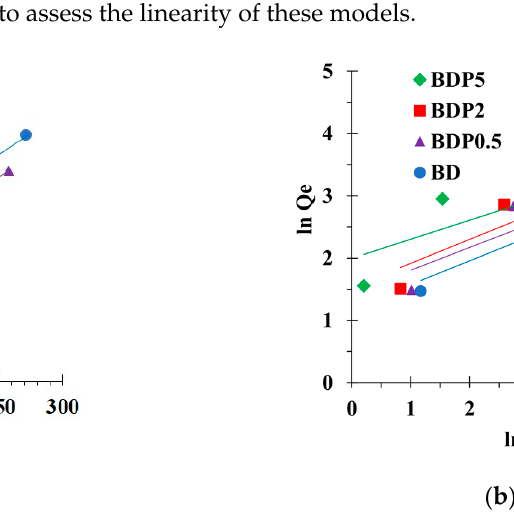
Figure 8. ( a ) Langmuir isotherm; ( b ) Freundlich isotherm of paraquat adsorption (conditions: 5 g/L of adsorbent dosage, 360 min of contact time, pH of 8, and temperature at 303 K). Isotherm parameters are displayed in Table 4. The correlation coefficient (R 2 ) was essentially superior for the Langmuir isotherm model (R 2 = 0.9997, 0.9993, 0.9980, and 0.9988) than the Freundlich isotherm model (R 2 = 0.9162, 0.7267, 0.8253, and 0.8236) for BD, BDP0.5, BDP2, and BDP5, respectively. Table 4. Langmuir and Freundlich isotherm parameters (conditions: 5 g/L of adsorbent dosage, 360 min of contact time, pH of 8, and temperature at 303